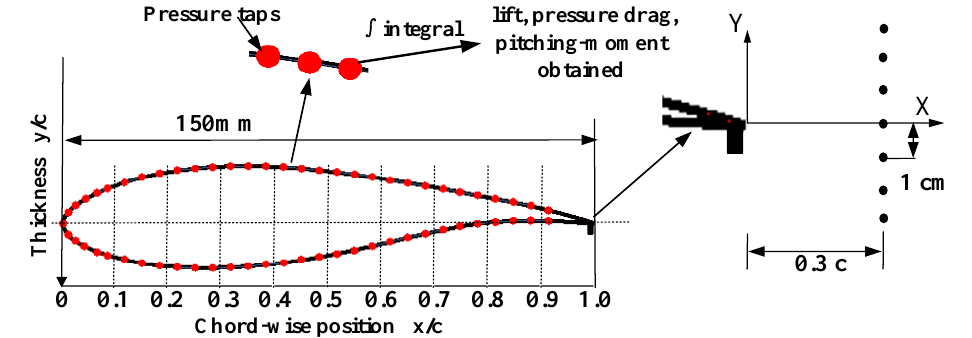
Figure 2. Schematic diagram of the DTU-LN221 airfoil used in the experiment.